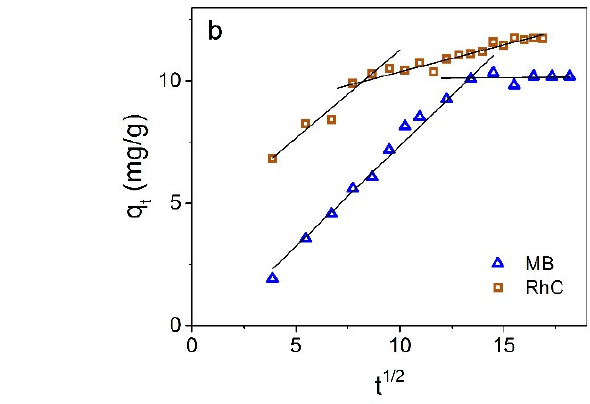
Table 3. Parameters of the best nonlinear fitting of the experimental adsorption data for Fe 3 O 4 @C NPs to the pseudo-first- and pseudo-second-order kinetic models. Parameters of the Nonlinear Fit